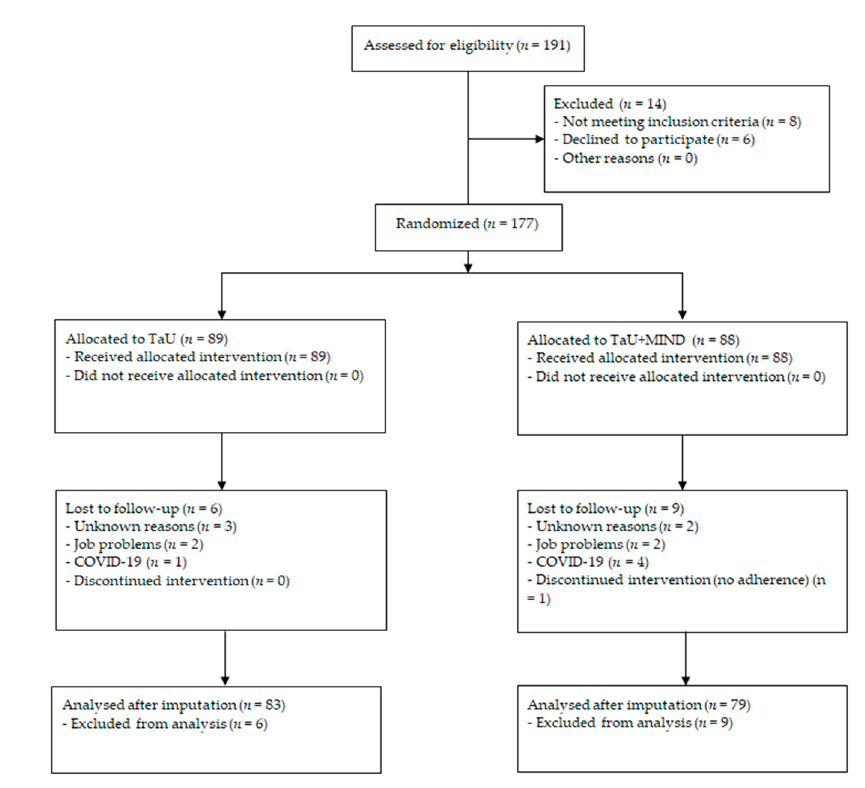
Figure 1. Study flowchart.